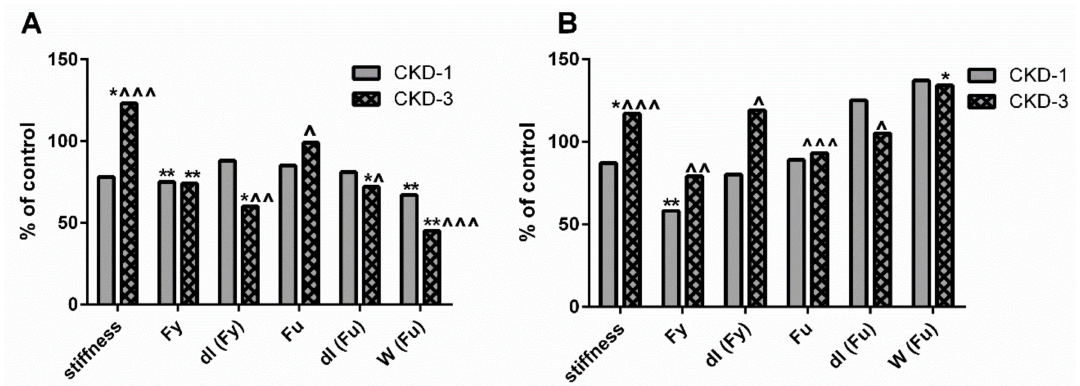
Figure 7. Schematic representation of the changes in biomechanical properties at trabecular ( A ) and cortical ( B ) level of femoral bone of young rats with chronic kidney disease (CKD). Data relate to control taken as 100%. * p < 0.05, ** p < 0.01 CKD versus appropriate controls; ˆ p < 0.05, ˆˆ p < 0.01, ˆˆˆ p < 0.001 CKD-3 versus CKD-1; Abbreviations: CKD = chronic kidney disease; CKD-1 = subtotal nephrectomized rats, 1 month after surgical intervention; CKD-3 = subtotal nephrectomized rats, 3 month after surgical intervention; Fy = yield load; dl (Fy) = displacement at yield load; Fu = ultimate load; dl (Fu) = displacement at ultimate load, W (Fu) = work to fracture. Table 4. The association between bone biomechanics, KYN levels and bone turnover markers in the trabecular and cortical bone compartments.